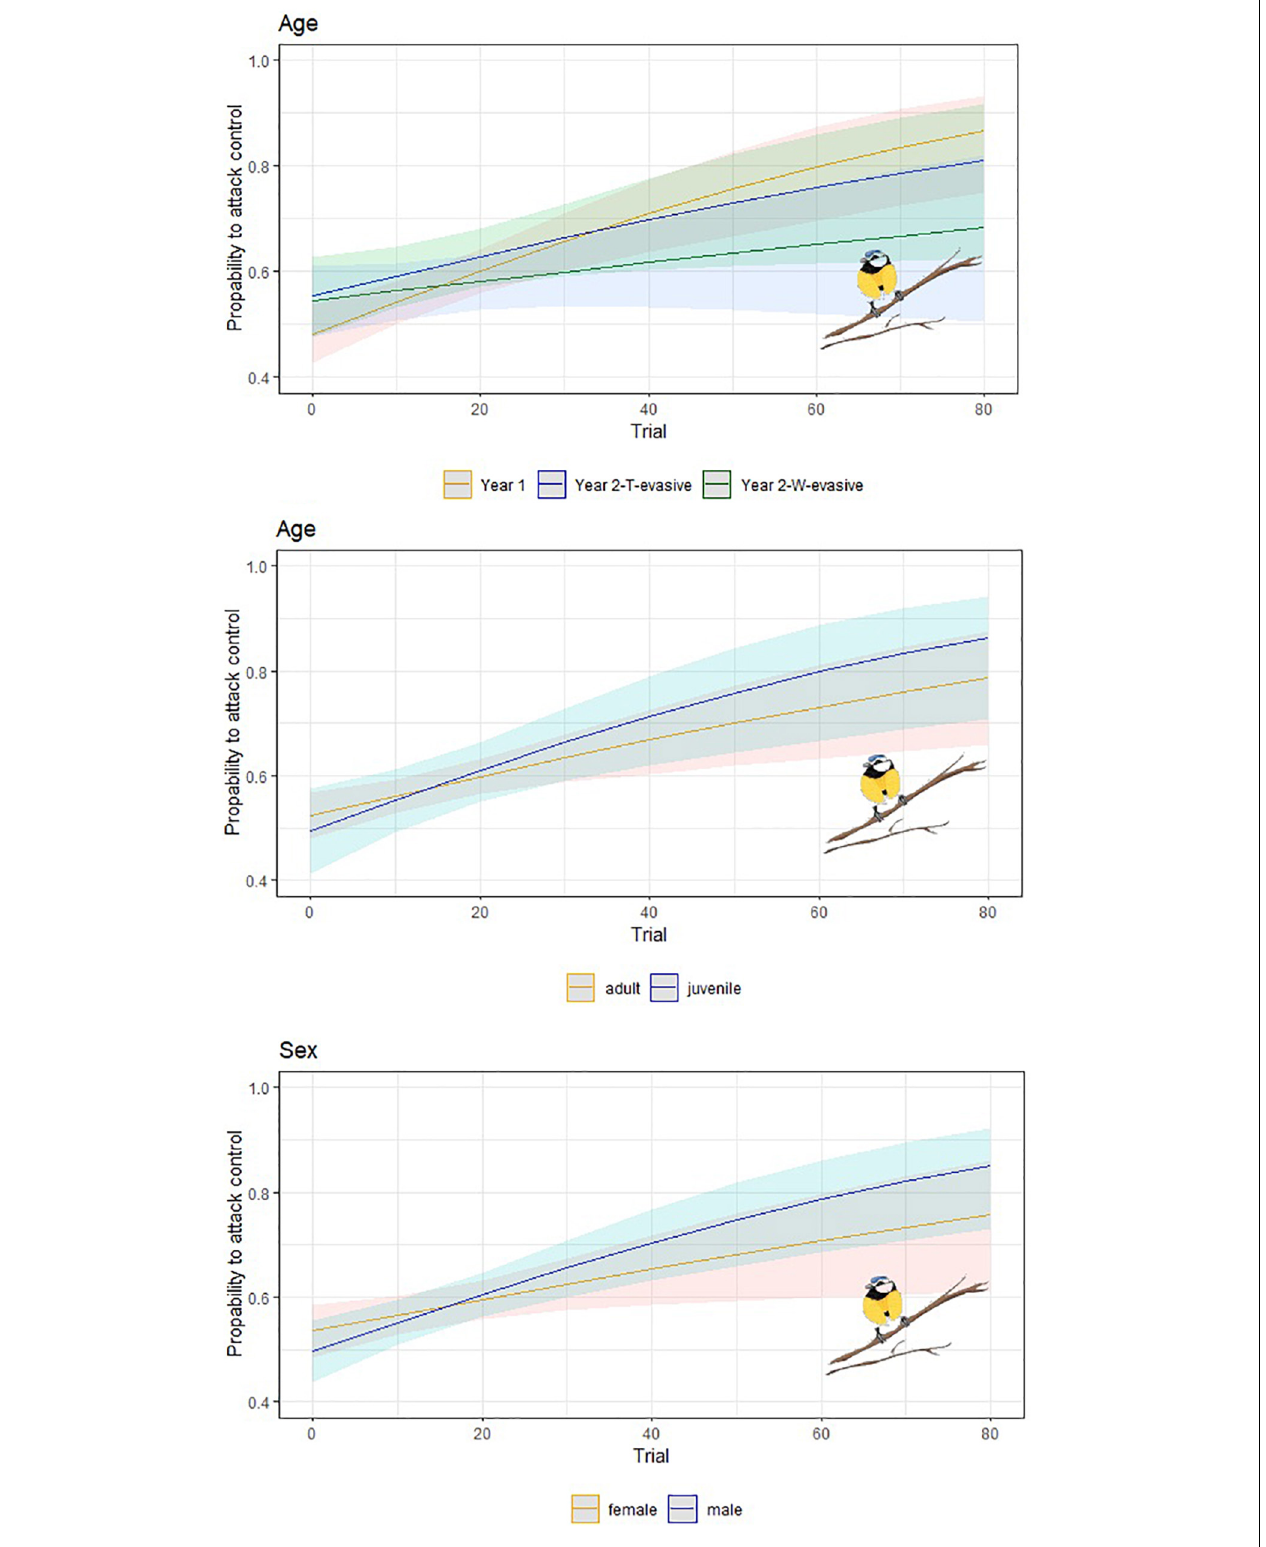
FIGURE 3 | Predicted probability of attacks targeting the escaping model by blue tits in dependence on the number of trials. Upper-left : learning behavior separated between different experiments; upper-right : difference in learning behavior between adult and juvenile birds; lower-left : difference between female and male ones. Including 95% confidence